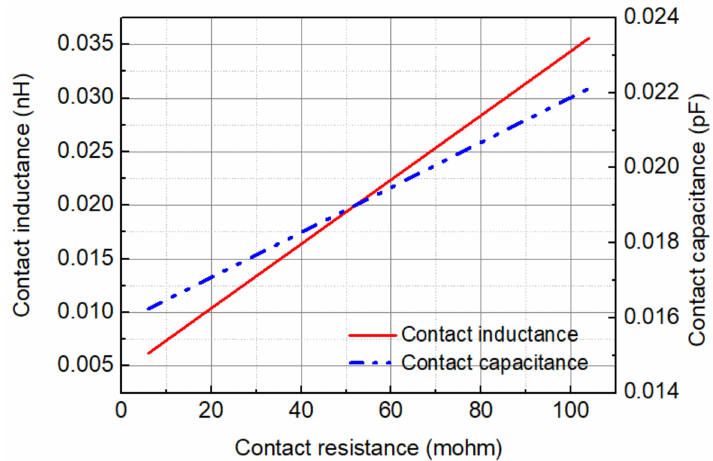
Figure 12. Relationship between the connection resistance R 3 , connection inductance L 3 and connection capacitance C 3 of the example solder ball. The function expressions are L 3 = 3 × 10 − 4 R 3 + 4.4 × 10 − 3 and C 3 = 6 × 10 − 5 R 3 + 0.01588. The unit of inductance, capacitance and resistance are nH, pF and m Ω ,